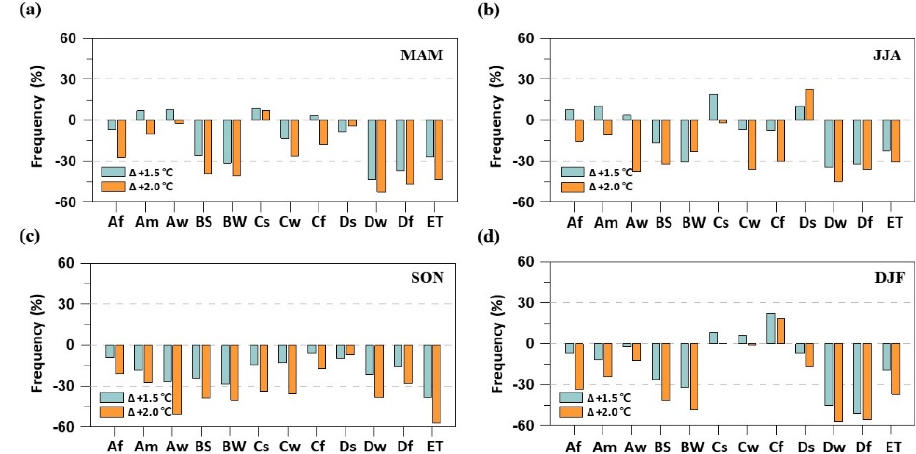
Figure 10. Relative changes in the ( a − d ) seasonal mean severity of severe drought (unit: %) based on SPI3 under 1.5 and 2.0 °C global warming compared to the reference period in the Asian monsoon region. Figure 11. Relative changes in the ( a – d ) seasonal mean frequency of severe drought (unit: %) based on SPI3 under 1.5 and 2.0 °C global warming compared to the reference period in the Asian monsoon region.